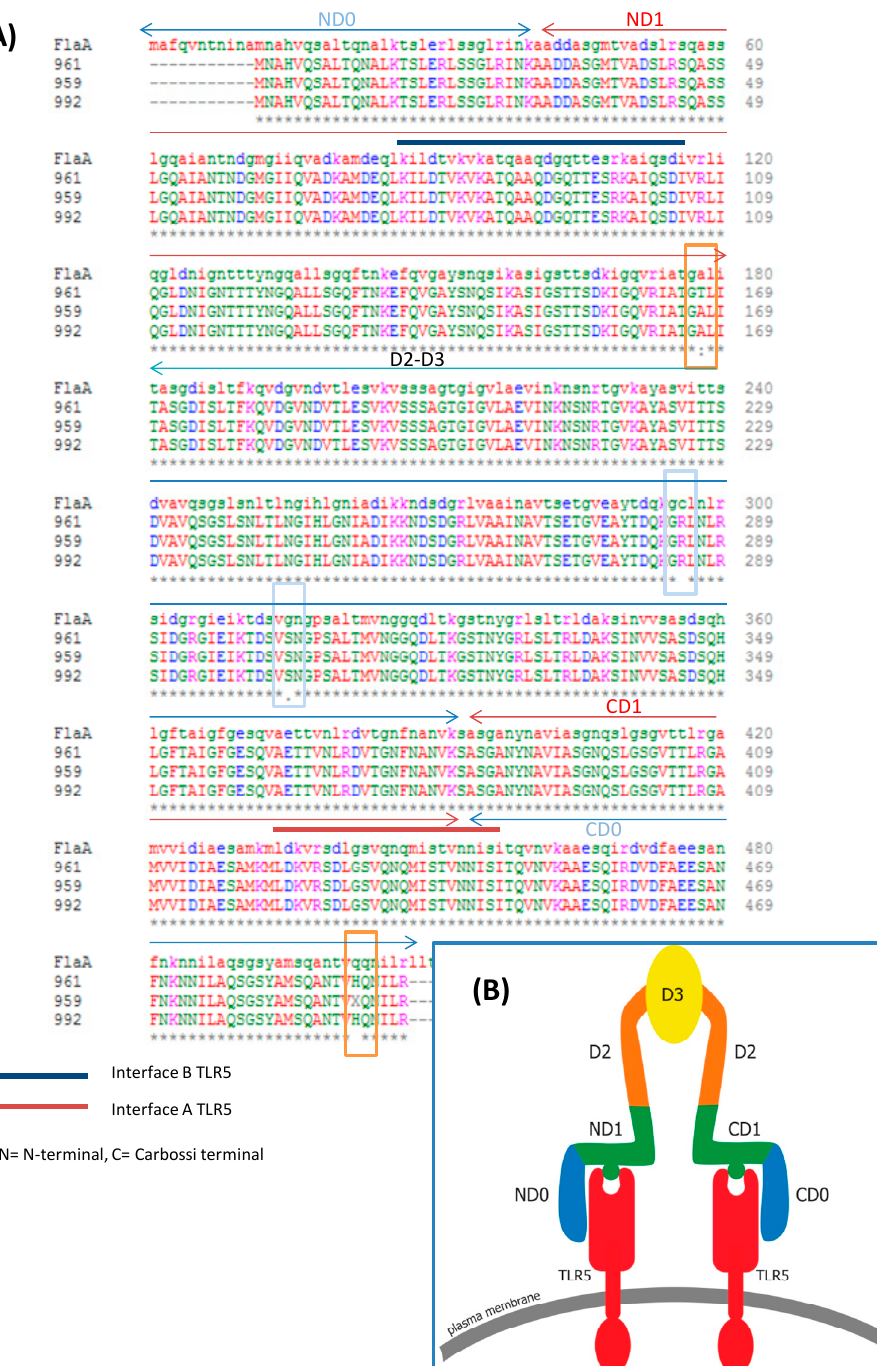
Figure 3. Multiple sequence alignment of flagellin A and schematic structure of flaA-TLR5 interaction. ( A ) The strains of H. pylori used as sources of DNA for FlaA sequencing were previously isolated from patients with GC and AAG. Two strains represent H. pylori isolated from the biopsy of AAG patient (sample 961 and 959), and one H. pylori strain isolated from the biopsy of a patient with GC (sample 992). Raw sequences of DNA samples were analyzed and compared to a reference sequence (FlaA) by using multiple BLAST CLUSTAL alignment analysis. ( B ) Schematic diagram of flagellin structure with respect to possible interactions with TLR5. D0 domain of flagellin is needed for the dimerization of TLR5 and it is recognized by both the C-terminal part of the TLR5 extracellular domain and the intracellular NOD-like receptor (NLRC4) of the inflammasome complex. Conserved residues in the D1 domain (indicated with blue and red lines in the figure) interface primarly with the groove TLR5 binding site.